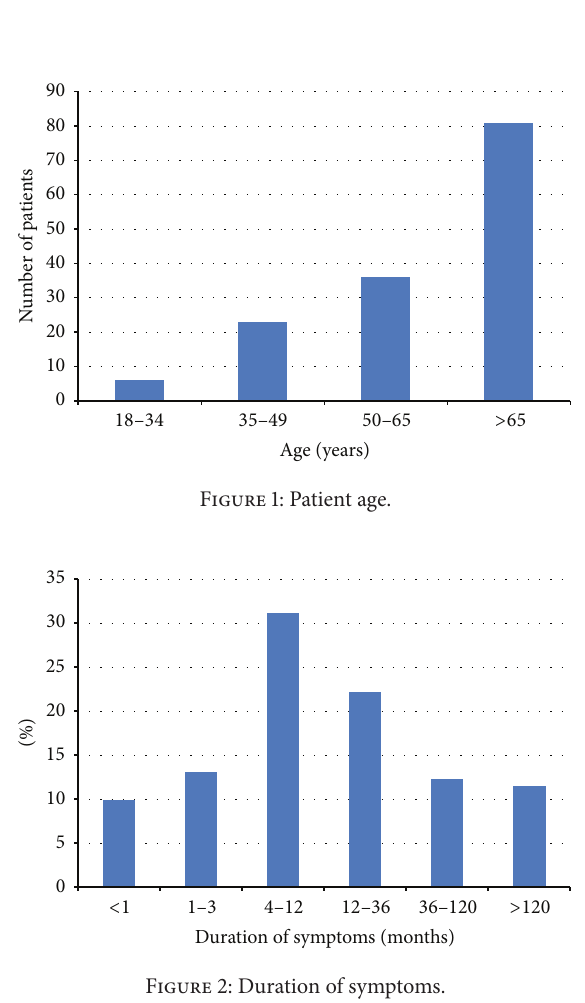
Figure 2: Duration of